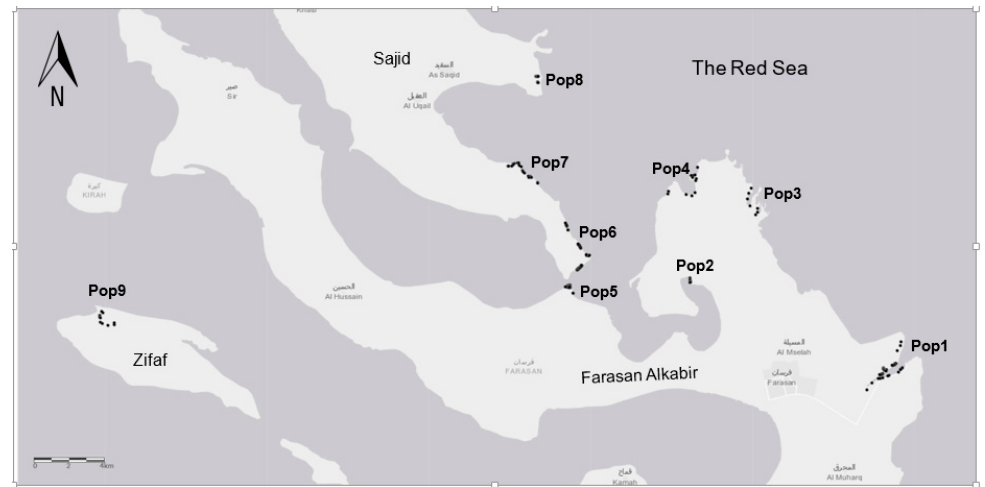
Figure 1. Geographical locations of the nine natural populations of Avicennia marina in the Farasan